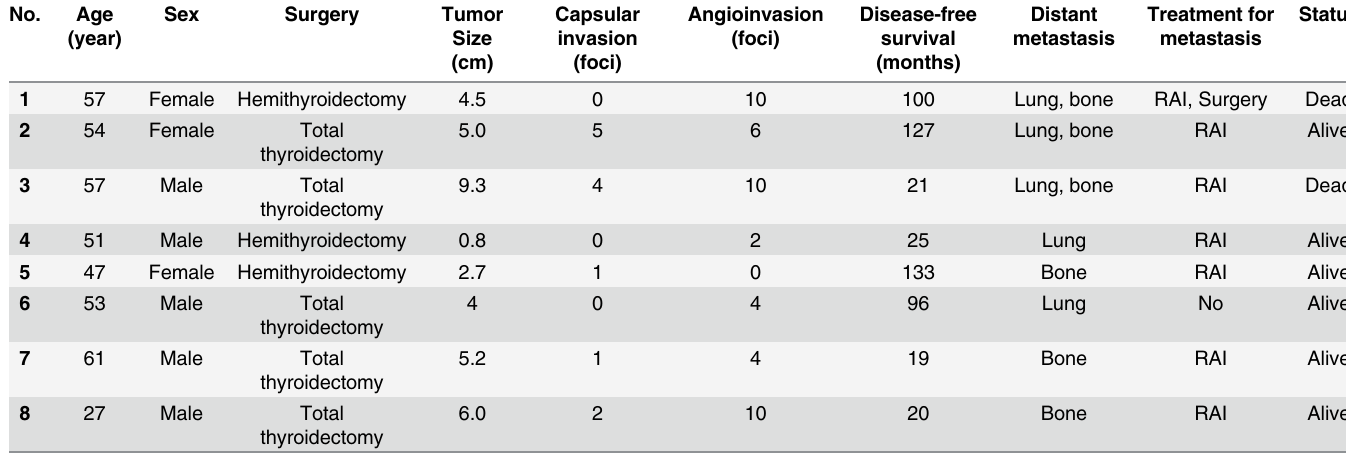
Table 2. Clinicopathologic characteristics of patients with distant metastasis.